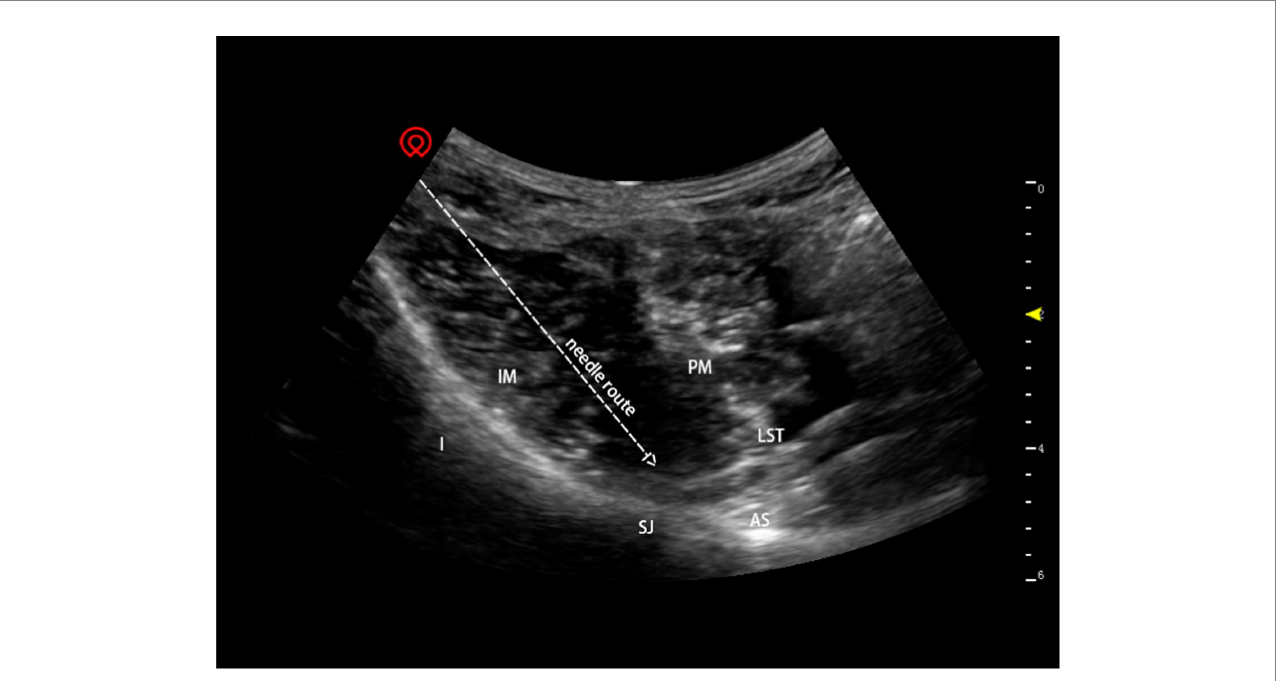
FIGURE 1 Ultrasound-guided anterior iliopsoas muscle space block. I: ilium; IM: iliac muscle; LST: lumbosacral trunk; PM: psoas muscle; SJ: sacroiliac joint; AS: alae